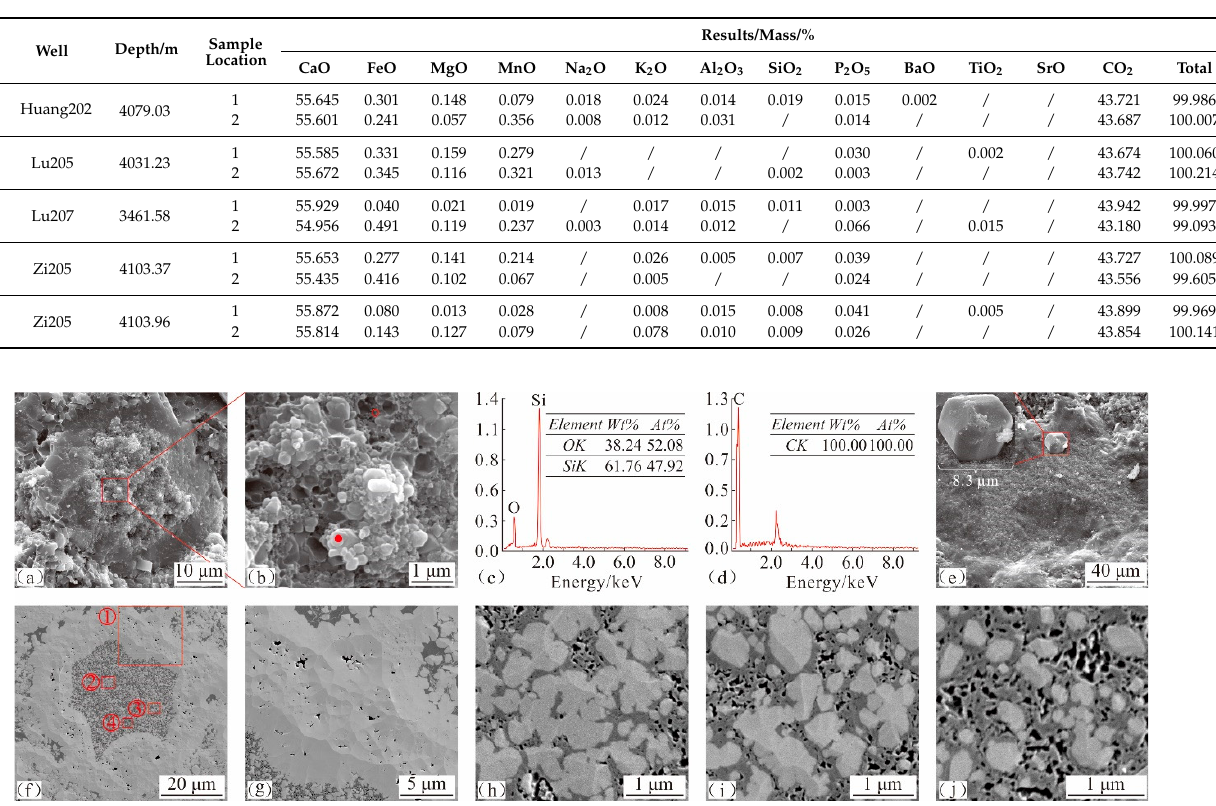
Figure 4. Typical SEM images and energy spectra of fillings in radiolarian siliceous shell cavities. ( a ) Complete radiolarian siliceous shell filled with organic–silicon complex. ( b ) Enlargement of the red box in image ( a ), organic–silicon complex. ( c ) Energy spectrum of siliceous particle in image ( b ). ( d ) Energy spectrum of organic matter in image ( b ). ( e ) Complete radiolarian siliceous shell filled with pyrite crystal. ( f ) Complete radiolarian siliceous shell filled with organic–silicon complex. ( g ) Enlargement of No. ① red box in image ( f ), pores of radiolarian siliceous skeleton. ( h ) Enlargement of No. ② red box of image ( f ), contacted silica particles with organic matter among them. ( i ) En ‐ largement of No. ③ red box of image ( f ), with equal silicon content and organic matter content. ( j ) Enlargement of No. ④ red box of image ( f ), scattered silica particles in organic matter. ( a , b , e ): Fresh surfaces. ( f – j ): Argon ‐ ion ‐ polished surfaces.